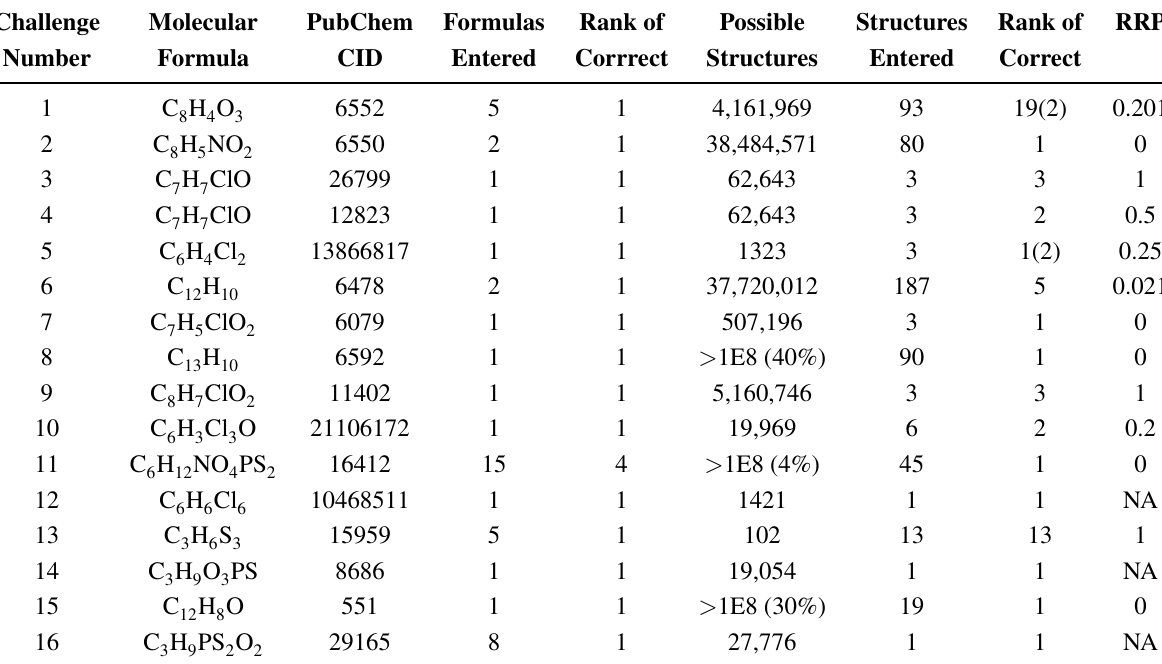
Table 3. MOLGEN–MS results for Categories 3 and 4 (best molecular formula and